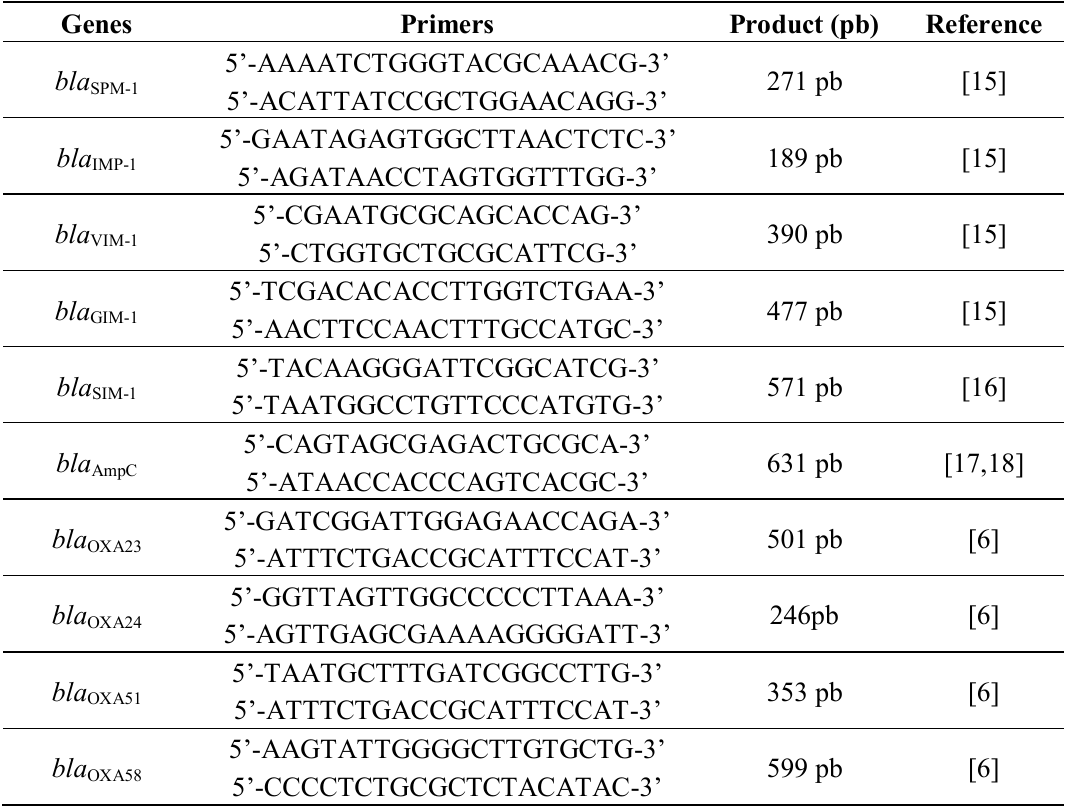
Table 1. Primers used for detection of β-lactamase genes in A. baumannii strains.